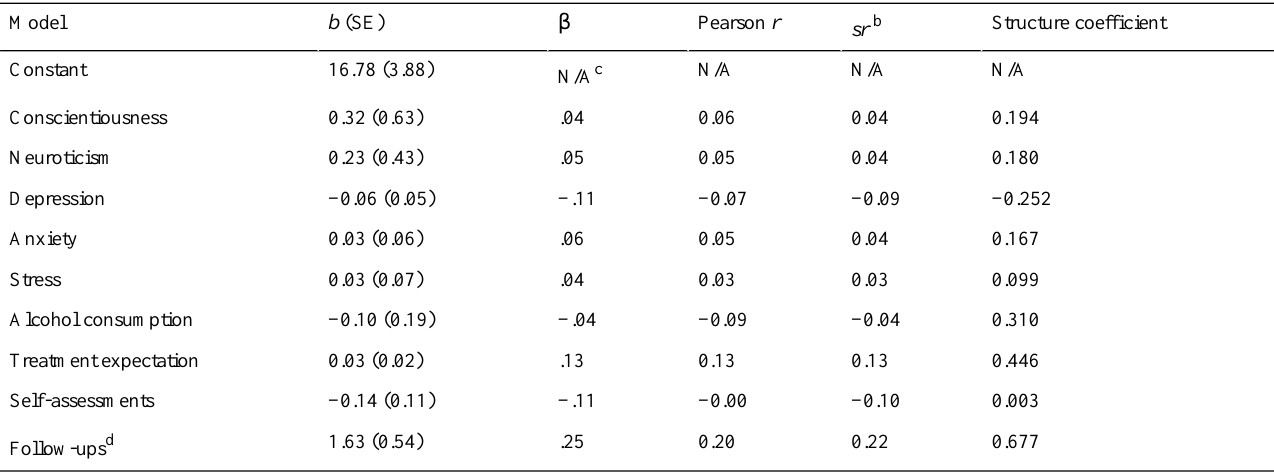
Table 5. Standard regression results for personality, negative affect, treatment expectations, and study engagement predicting treatment satisfaction (n=190) a .